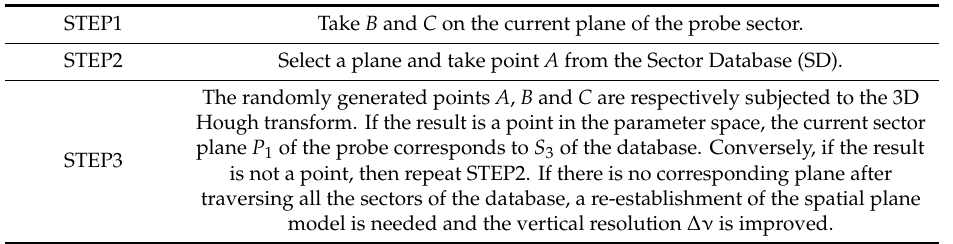
Table 3. Steps of the improved 3D Hough